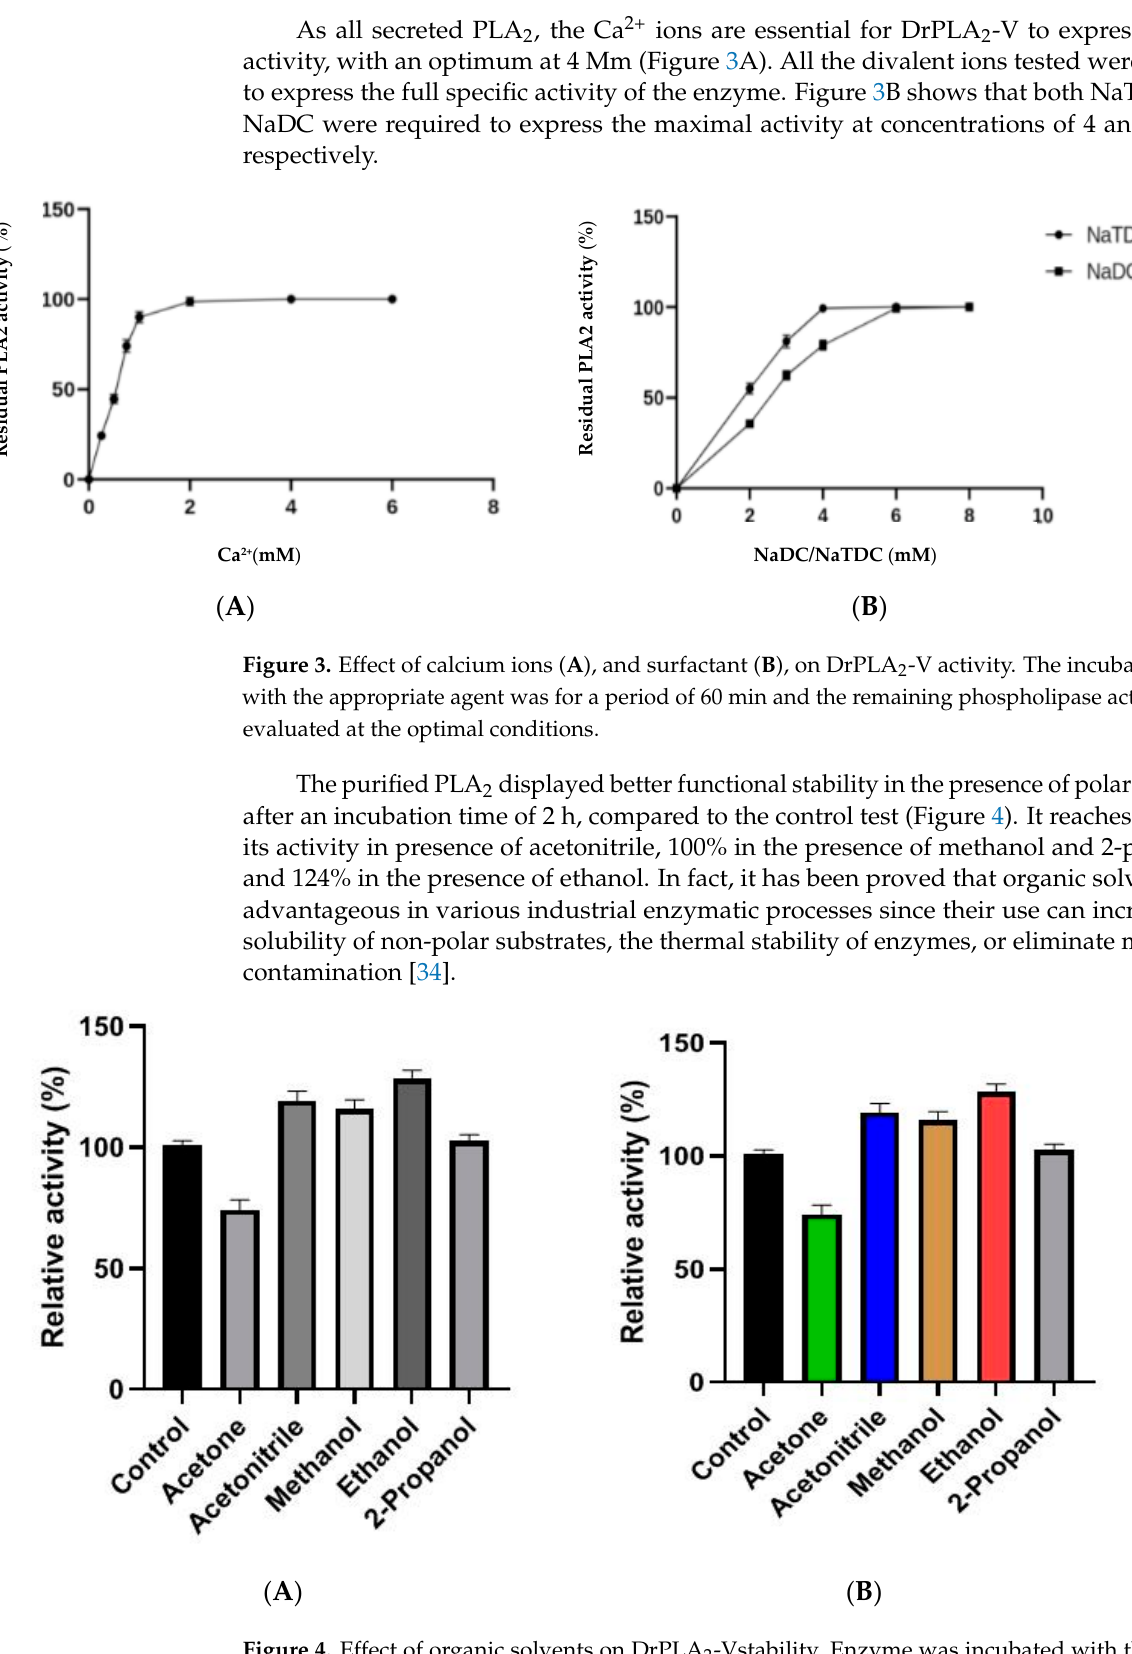
Figure 2. Evaluation of pH and temperature effect on activity ( A , B ) and stability ( C , D ) of DrPLA 2 - V.